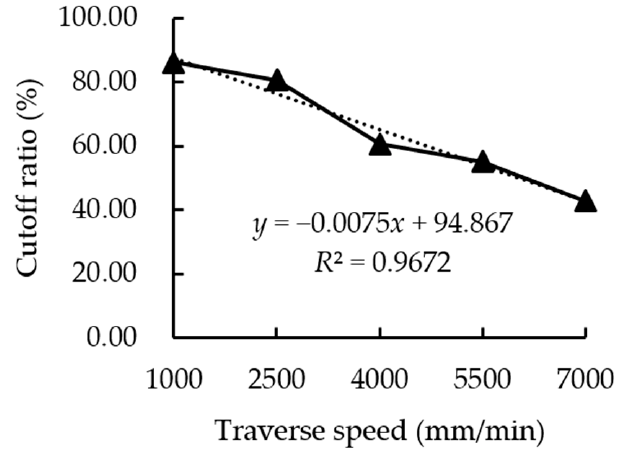
Figure 8. Influence of the traverse speed on the cutoff Figure 8. In fl uence of the traverse speed on the cuto ff ratio.